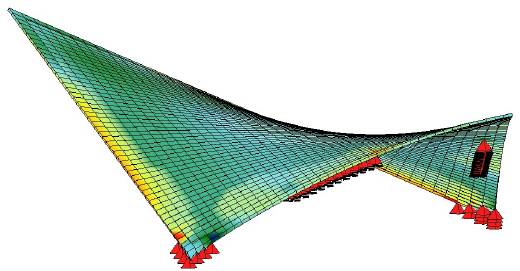
Figure 12: Finite element model FE4, with support points at masonry walls